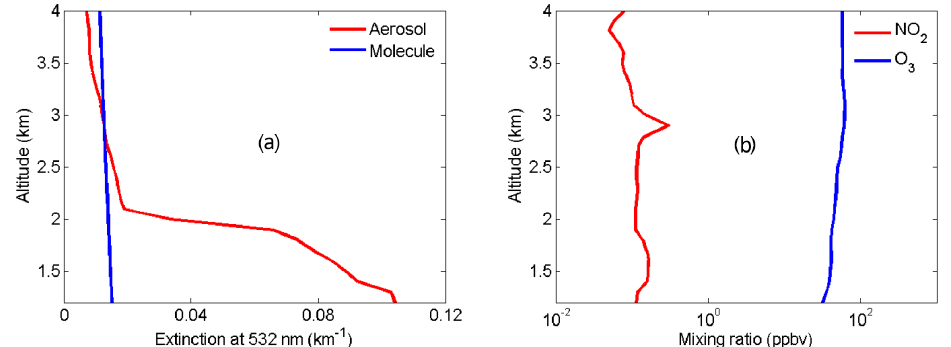
Figure 5. Atmospheric profiles used for modeling NO 2 lidar correction terms. (a) Aerosol extinction profile (red) at 532nm measured by the HU lidar and molecular extinction profile (blue) at 532nm derived from local radiosonde data, (b) NO 2 (red) and O 3 (blue) mixing ratio profiles from NASA DISCOVER-AQ and